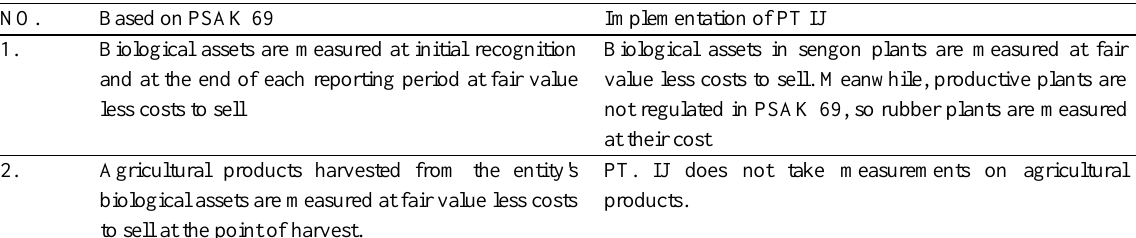
Table 4: Agricultural Activity Measurement